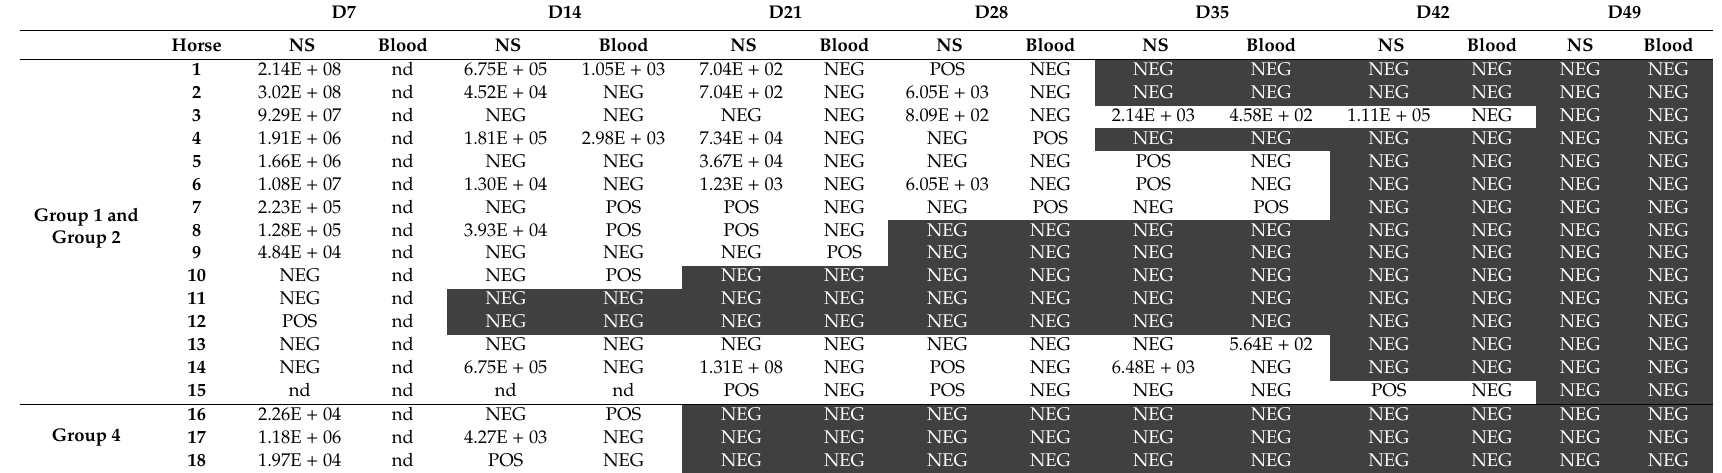
Table 3. Monitoring of the viral shedding on 14 horses from groups 1, 2, and 3 over a period of seven weeks (copy /